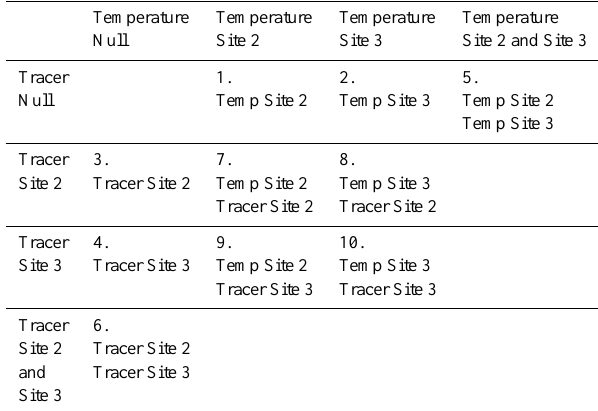
Table 1. Simulation matrix of ten single (1–4) and two-objective (5–10) calibrations combining main channel temperature and tracer observations at two locations (Site 2 and Site